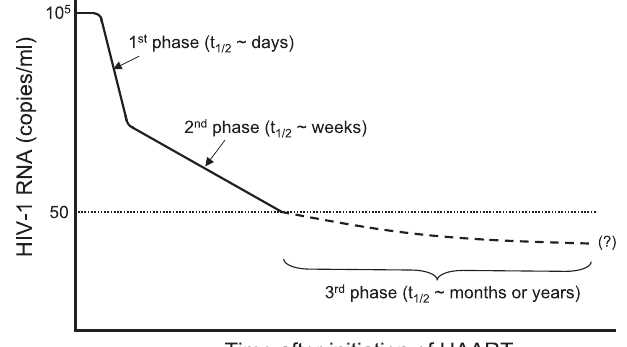
Figure 1. A Schematic Illustration of the Decay Dynamics of HIV-1 after the Initiation of Highly Active ART DOI: